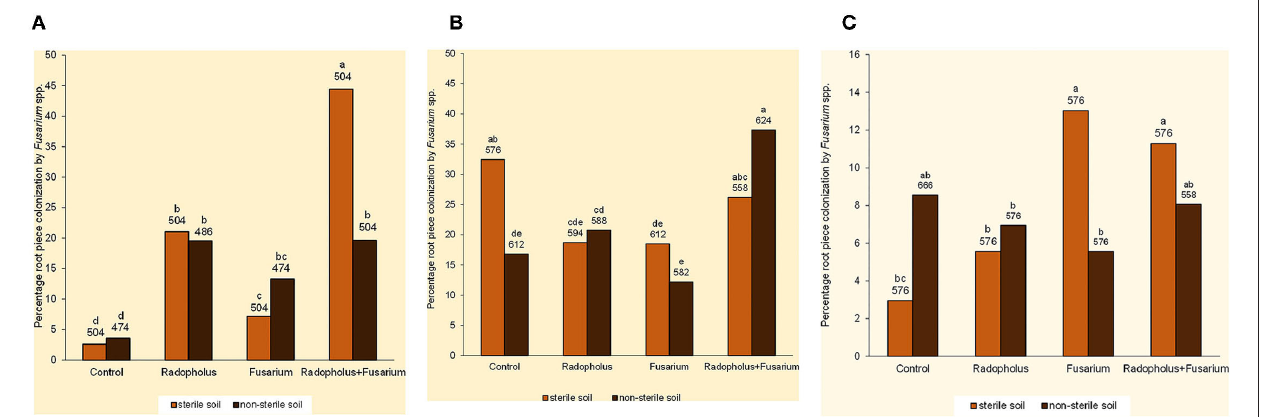
FIGURE 2 | Root colonization by endophytic Fusarium spp. in (A) nitrogen-starved, (B) phosphorus-starved, and (C) potassium-starved tissue culture banana plants subjected to independent or combined inoculation with Radopholus similis and the Fusarium oxysporum V5w2 and grown in sterile or non-sterile soil. Bars with the same letter represent values that are not statistically different, with the sample sizes indicated below the letters ( χ 2 -test, p < 0.05).